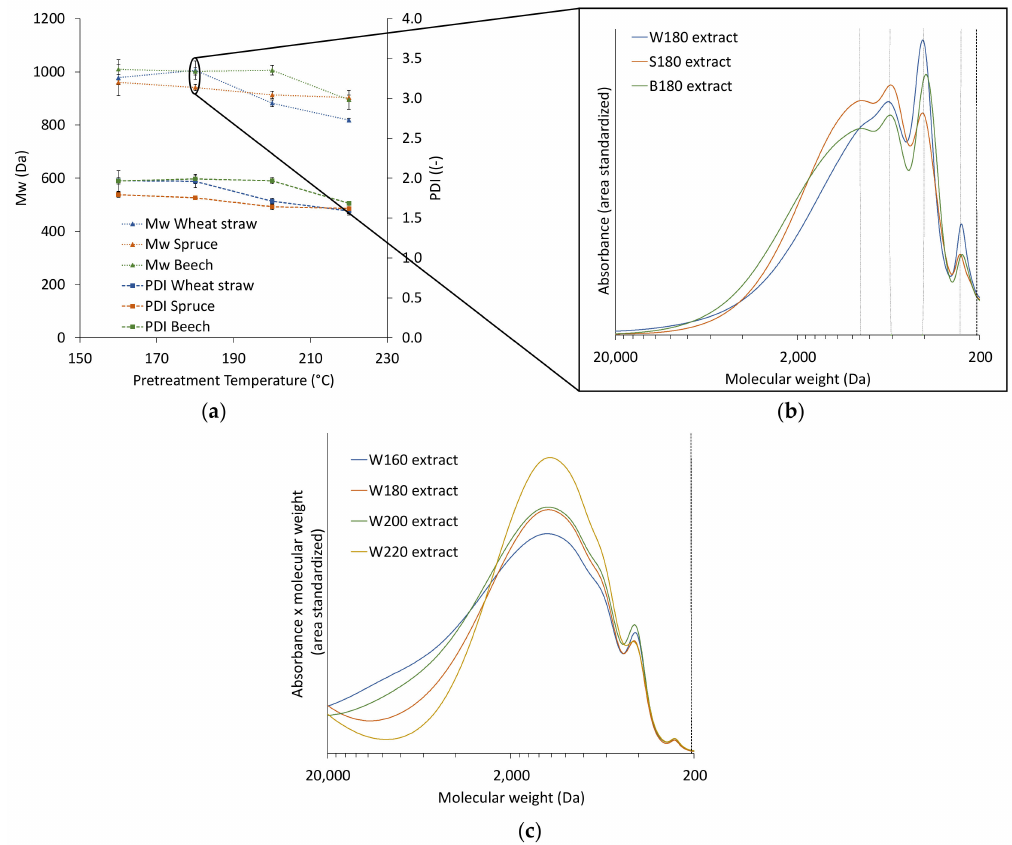
Figure 3. M w and PDI of the extracts from the different raw materials ( a ), molecular weight distribution of extracts from different raw materials at 180 ◦ C ( b ), and molecular weight distribution of wheat straw at different pretreatment temperatures ( c ). Abbreviations: W—wheat straw, S—spruce, B—beech; the number next to the letter is the temperature of the corresponding pretreatment temperature.